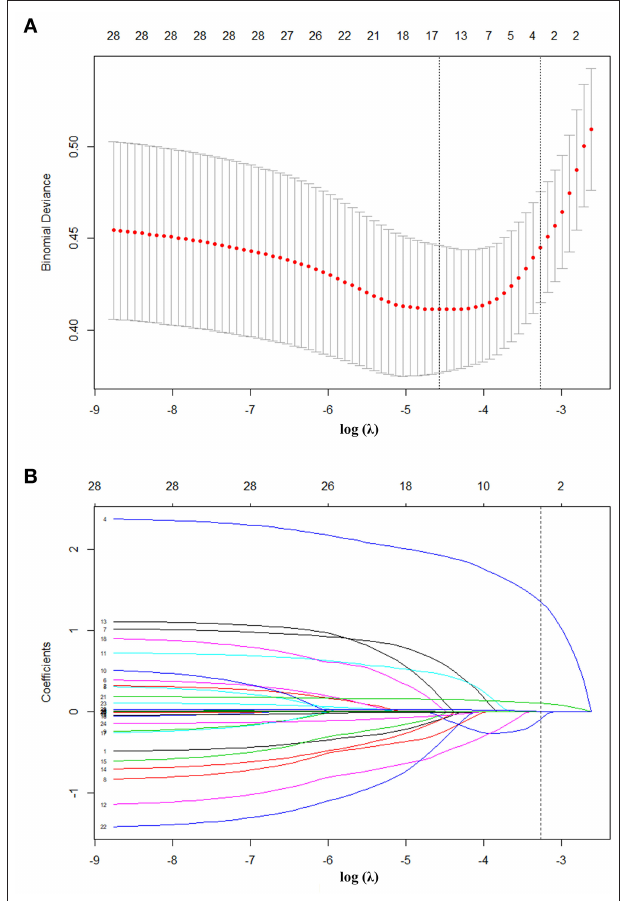
FIGURE 2 | Texture feature selection using the LASSO binary logistic regression model. (A) Tuning parameter ( λ ) selection in the LASSO model used 10-fold cross-validation via minimum criteria. The AUC curve was plotted vs. log ( λ ). Dotted vertical lines were drawn at the optimal values by using the minimum criteria and the 1 standard error of the minimum criteria (the 1-SE criteria). A λ value of 0.038, with log ( λ ), 3.273 was chosen (1-SE criteria) according to 10-fold cross-validation. (B) LASSO coefficient profiles of the 28 texture features. A coefficient profile plot was produced against the log ( λ ) sequence. Vertical line was drawn at the value selected using 10-fold cross-validation, where optimal λ resulted in 4 non zero coefficients. AUC, area under the receiver operating characteristic; LASSO, least absolute shrinkage and selection